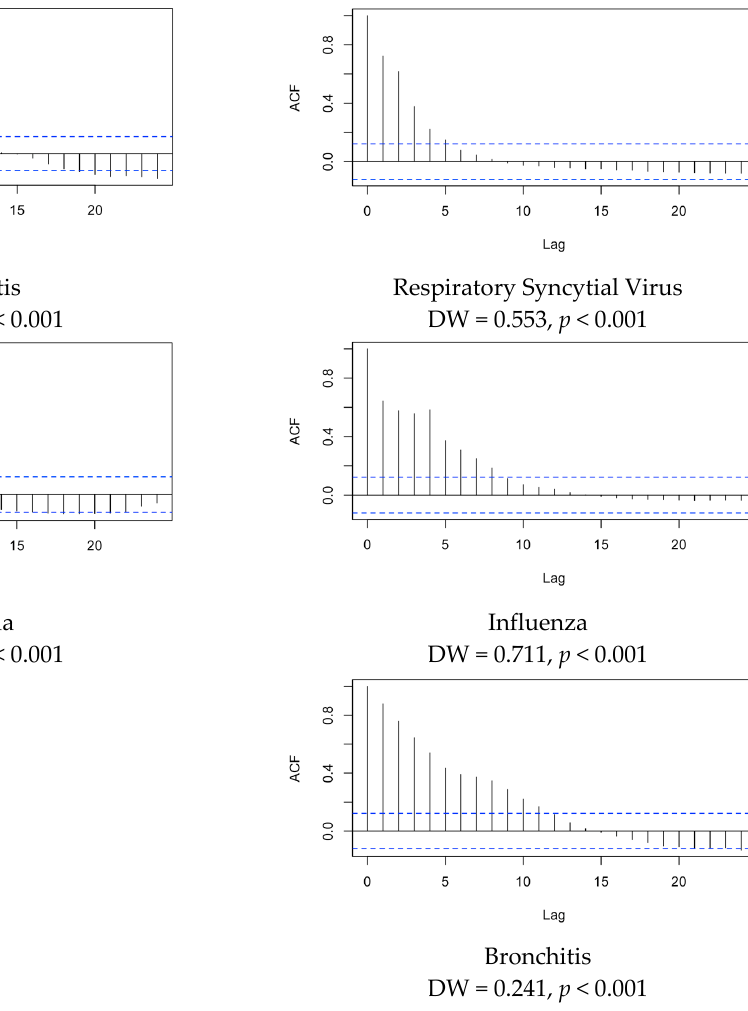
Figure A6. Autocorrelation plots for hit searches during the assessed timeframe (2017–2022), winter months only. Note: ACF = autocorrelation factor; DW = Durbin Watson coefficient. Values of DW coefficient > 2.0 rule out annual cyclical pattern. Table A1. Correlation between search volumes for RSV, respiratory syncytial virus, and Bronchiolitis, keywords from Google Trends TM .